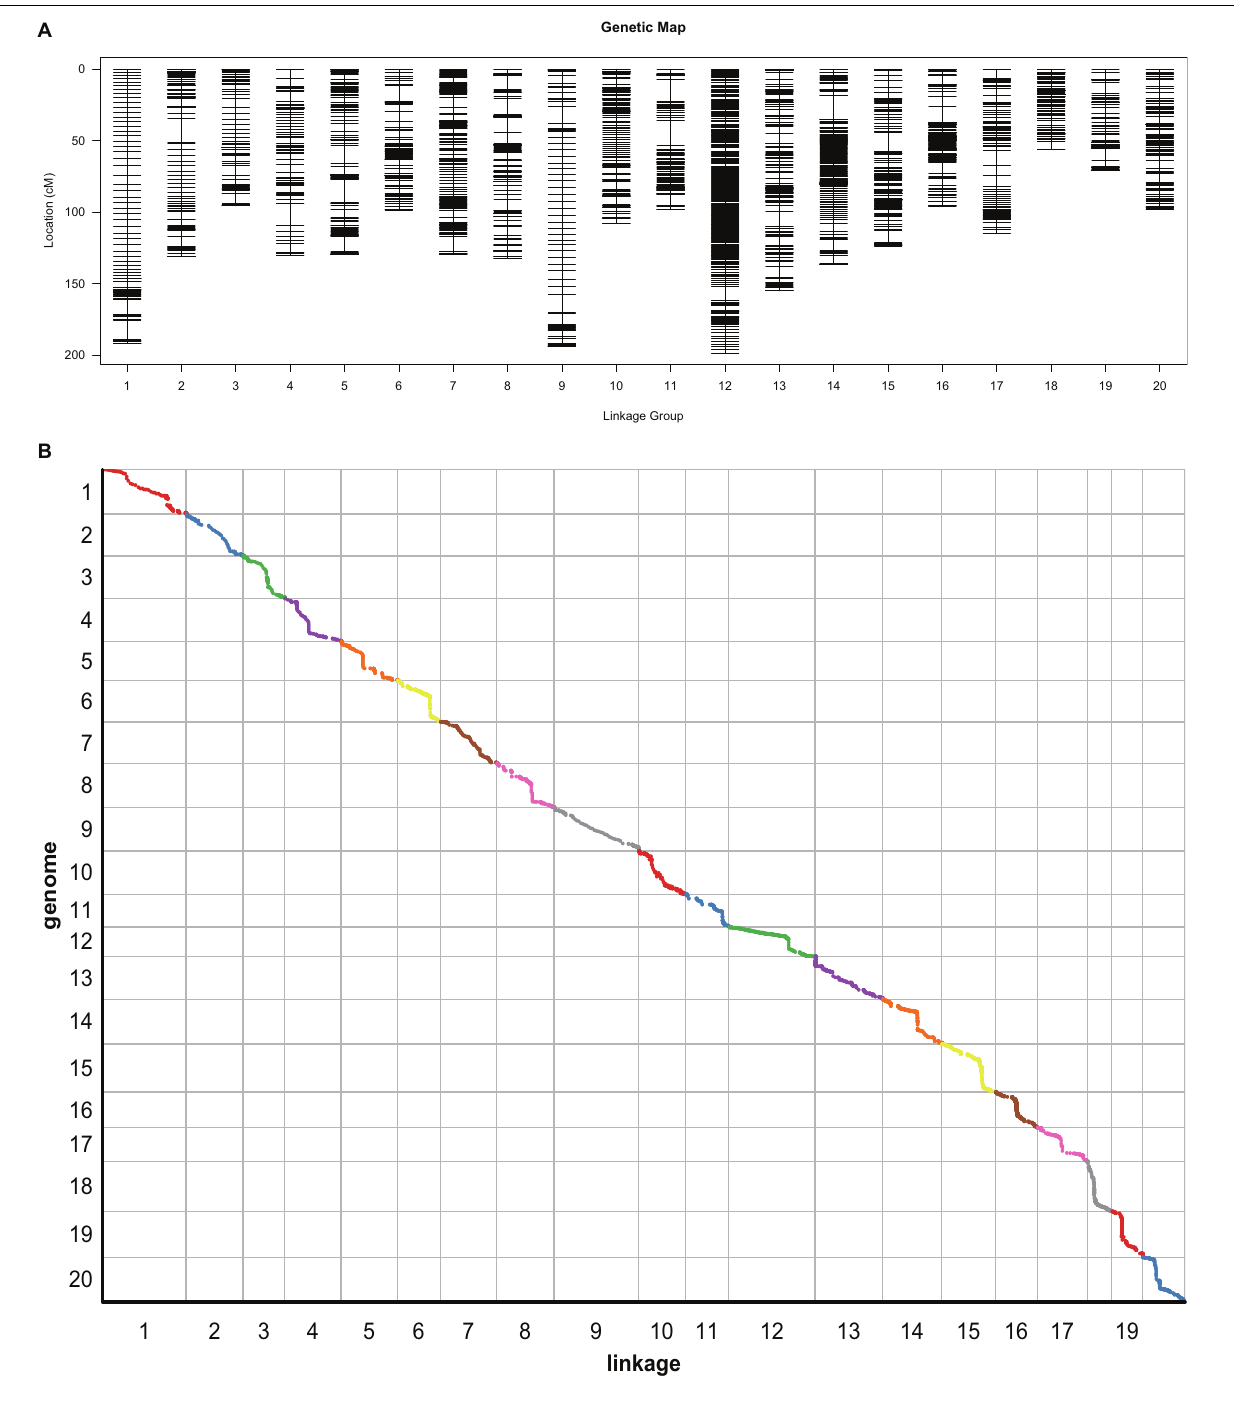
FIGURE 5 | The genetic map based on the ZH recombinant inbred lines (RIL) population. (A) The high-density genetic map. (B) The collinearity analysis between genetic map and genome. The slope of the line in each block means the Spearman correlation coefficient.